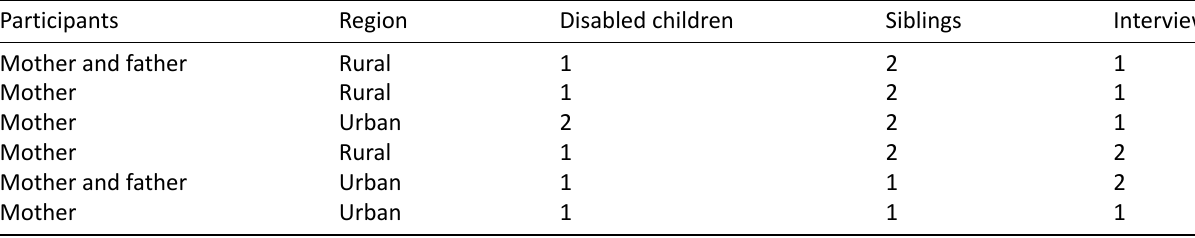
Table 1. Information about the